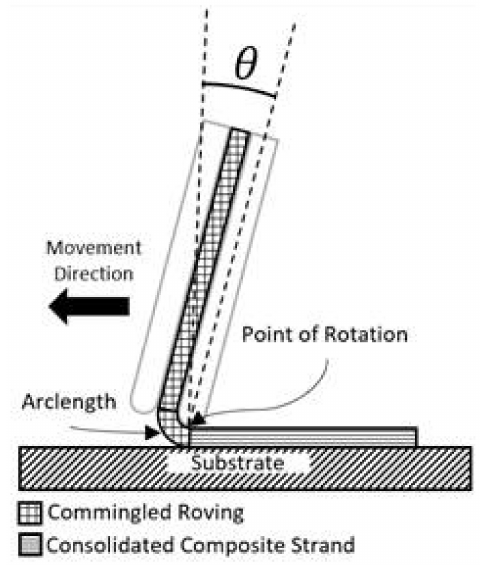
Figure 9. Tow spreading